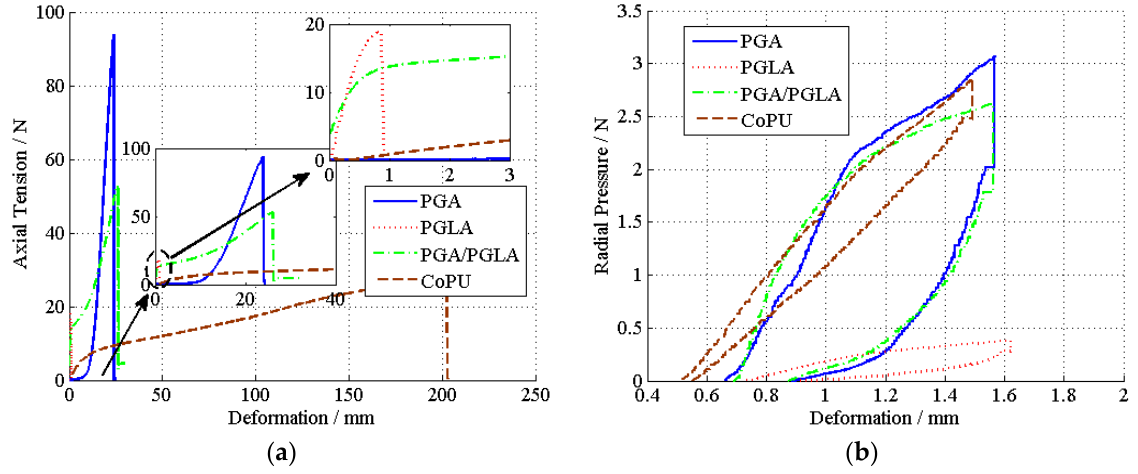
Figure 4. The strain forces corresponding to their deformations, axial tension is shown in ( a ) and radial compressure is shown in ( b ).